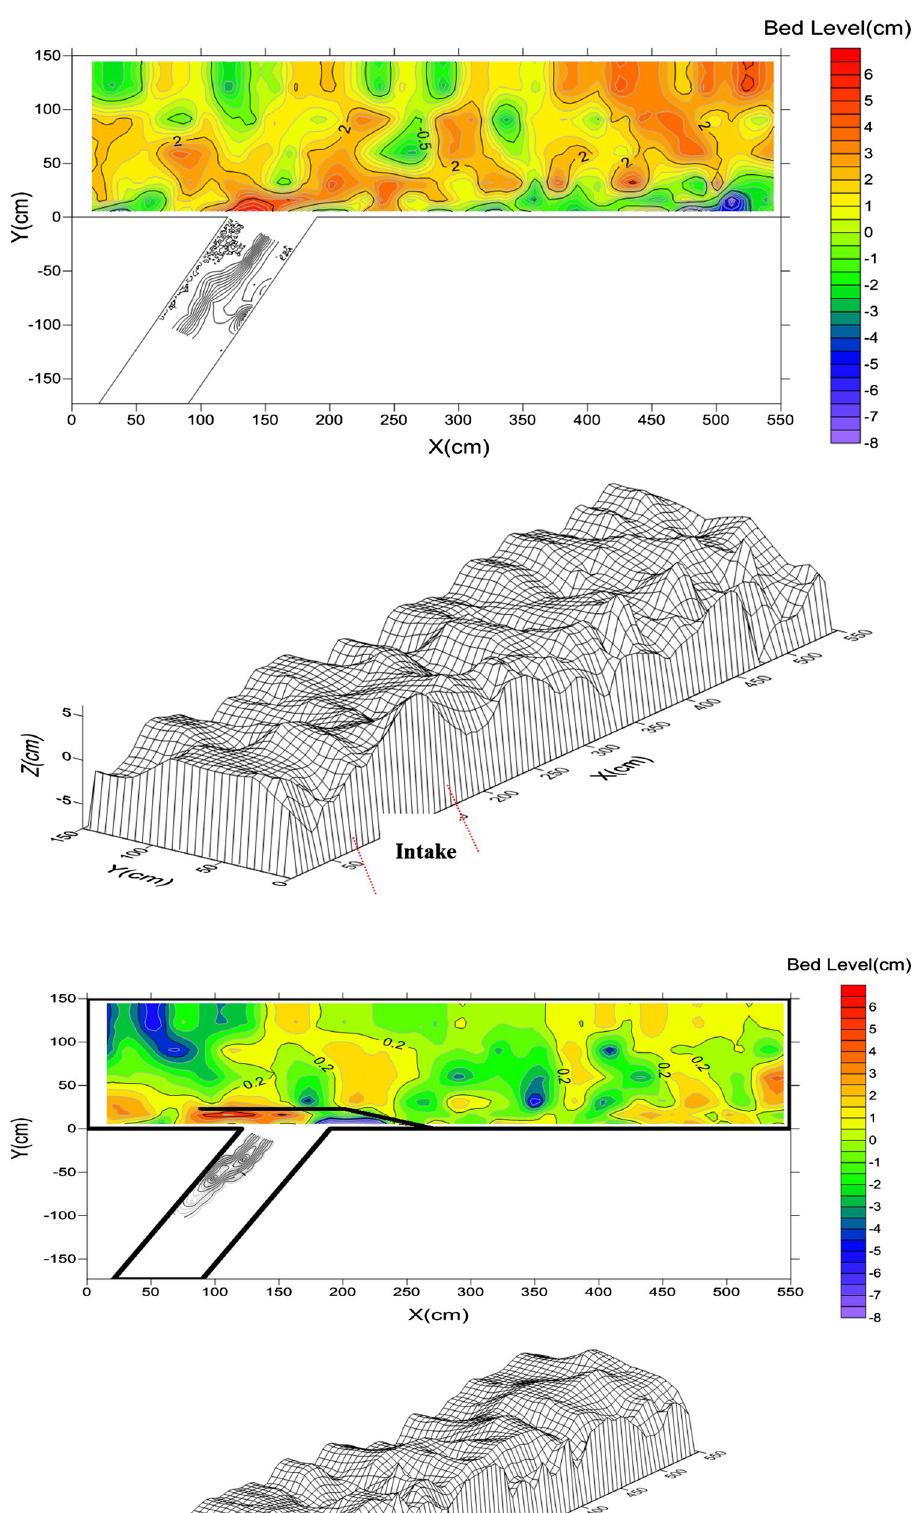
Fig. 6 Bed topography in the main channel without skimming wall ( Q = 0.06 m 3 /s)